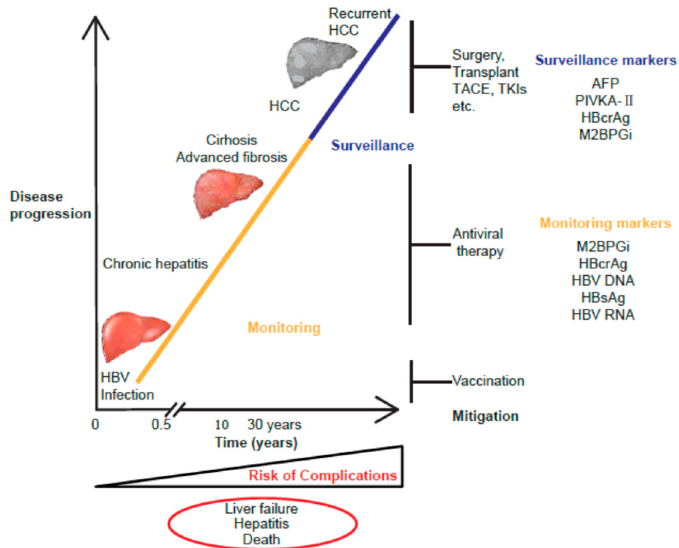
Figure 1. Chronic hepatitis B virus (HBV) infection related to liver disease progression. The schematic shows the clinical stages involved in the natural history of chronic hepatitis B (CHB). The novel serum biomarkers hepatitis B core-related antigen (HBcrAg) and Mac-2 binding protein glycosylation isomer (M2BPGi) provide valuable prognostic data for e ff ective management of CHB. It is important to monitor the patients at high risk and to treat them in order to prevent liver complications, cirrhosis, and hepatocellular carcinoma (HCC) development. Abbreviations: HBV, hepatitis B virus; HCC, hepatocellular carcinoma; TACE, transcatheter arterial chemoembolization; TKIs, tyrosine kinase inhibitors; AFP, alpha fetoprotein; PIVKA-II, protein induced by vitamin K absence or antagonist-II; HBcrAg, hepatitis B core-related antigen; M2BPGi, Mac-2 binding protein glycan isomer; HBsAg, hepatitis B surface antigen.